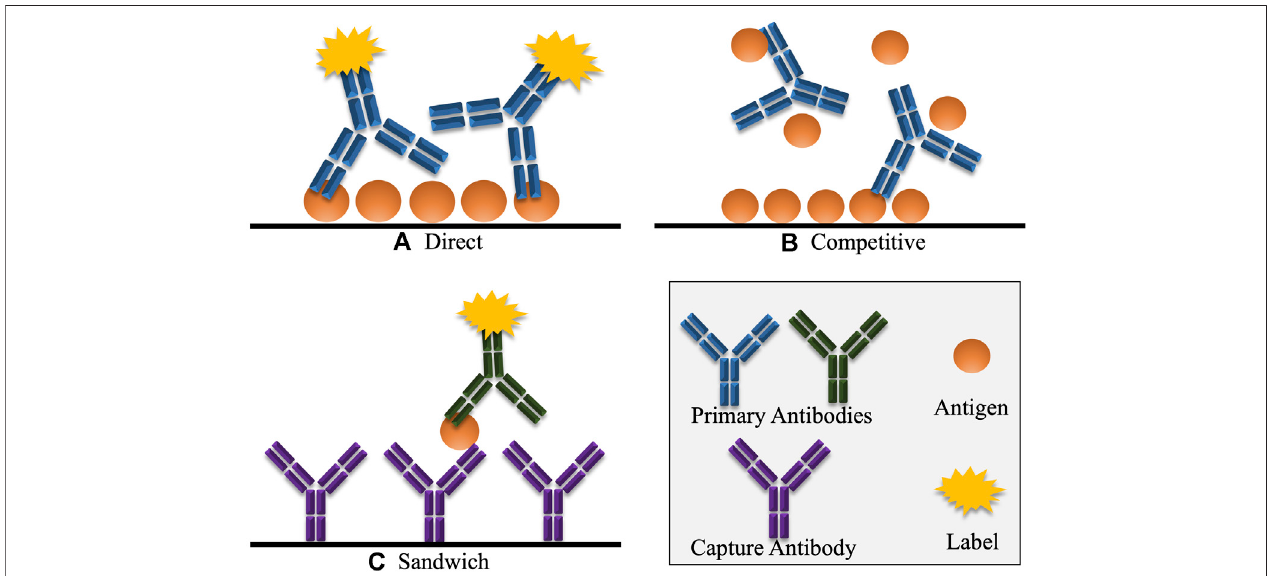
FIGURE 6 | Various common formats of immunoassays, including ELISA. (A) In direct detection, the antigen is detected directly by a labelled antibody. Indirect detection is a variation of this format, where the primary antigen-speci fi c antibody is unlabelled, and must be detected by a secondary labelled antibody that selectively binds to the primary antibody. (B) In competitive detection, free antigen in the sample competes with immobilised antigen for binding to the antibody which may be directly labelled or may be detected using a secondary labelled antibody. Hence, in competitive immunoassays, the signal is inversely proportional to the concentration of antigen. (C) In the sandwich immunoassay format, the antigen is captured by an antibody that reacts with a speci fi c epitope on the antigen. A second labelledantibodyisaddedwhichreactswithanotherdifferentepitopeonthecapturedantigen.Herethesignalgeneratedisdirectlyproportionaltotheamountofantigen present.